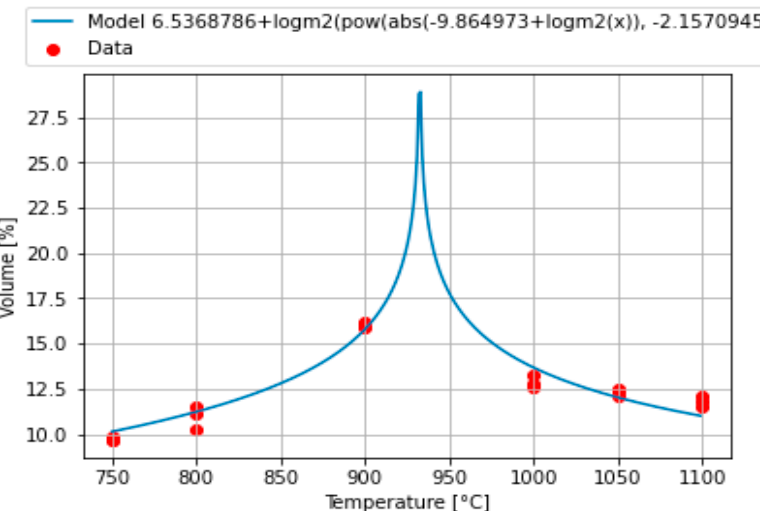
Figure 4. Model 3 of hydrogen H 2